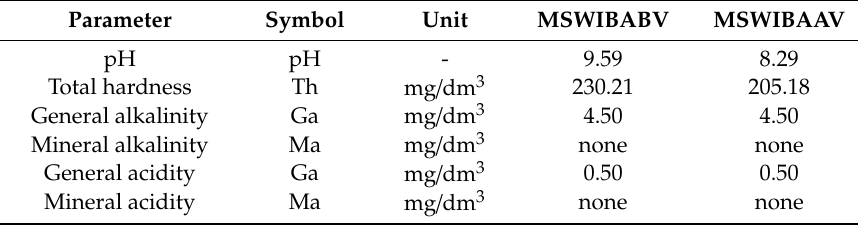
Table 5. Leachability of selected contaminants—Properties of the water extract of municipal solid